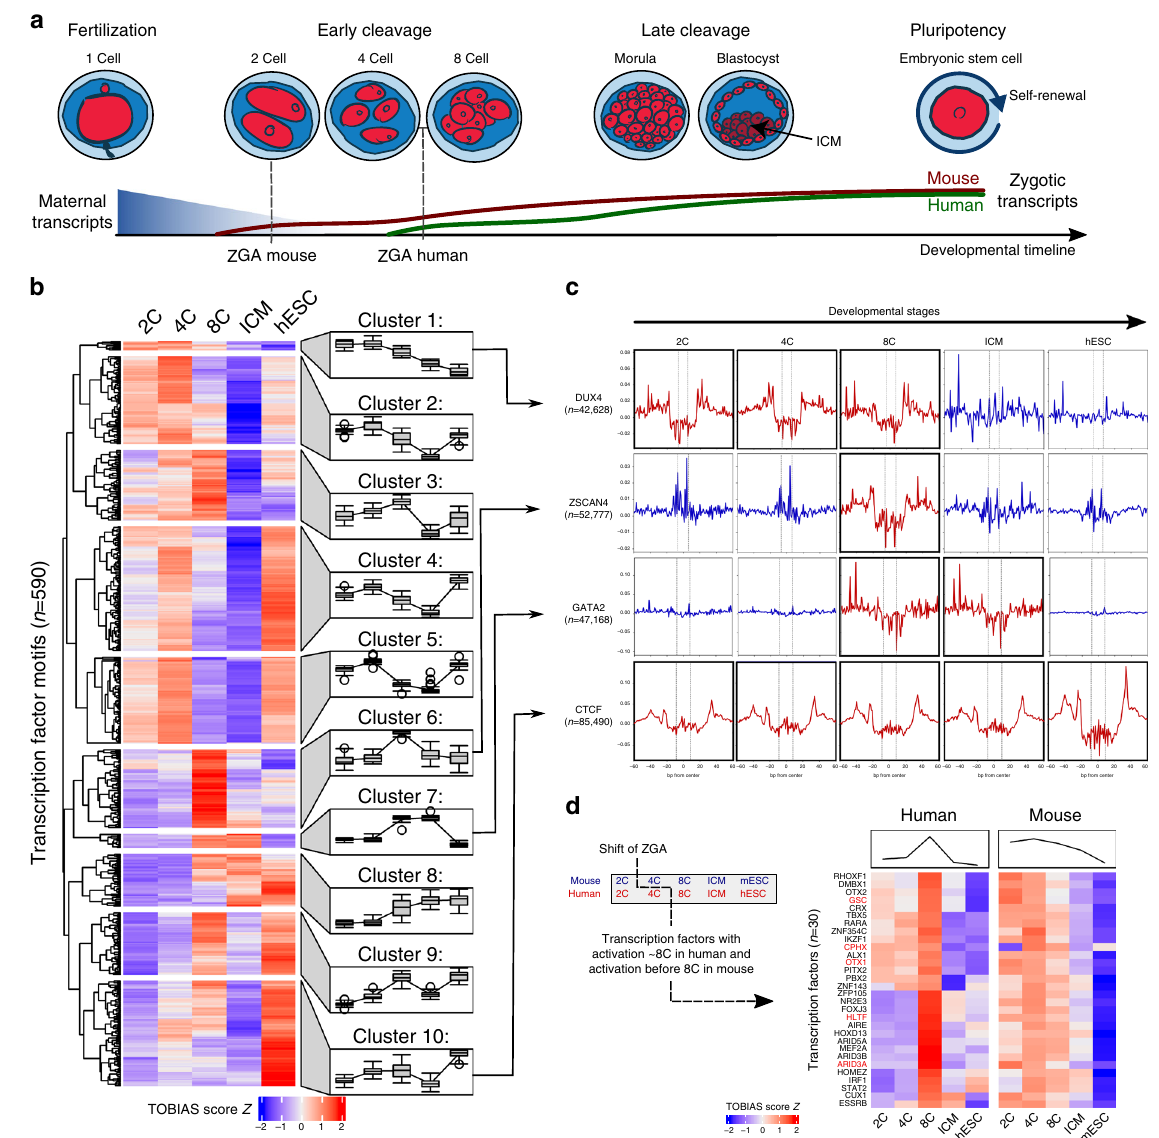
Fig. 2 Global changes in transcription factor binding throughout embryonic development. a Early embryonic development in human and mouse. While the fertilized egg undergoes a series of divisions, the maternal transcripts (blue curve) provided by the egg are depleted over time, and the zygotic genome is activated in waves (ZGA, red and green lines). ZGA initiates at the 2-cell stage in mouse and at the 4 – 8-cell stage in human. b Clustering of transcription factor activities throughout development. Each row represents one TF, each column a human developmental stage. TF activity scores from TOBIAS are Z - score transformed across rows. Blue color indicates low activity, red color indicates high activity. In order to visualize cluster trends, each cluster is associated with a mean trend line (left to right) and timepoint speci fi c boxplots respectively. Source data are available in the Source Data fi le. c Bias corrected ATAC-seq footprints. For selected TFs with known roles in early development originating from four clusters (arrows from b ), an aggregated footprinting plot matrix for all associated transcription factor binding sites is shown. Individual plots are centered around binding motifs ( n = asterisk (*) relates to the number of binding sites). Rows indicate TFs DUX4, ZSCAN4, GATA2, and CTCF; columns illustrate developmental stages from left to right. Active binding of the individual TFs is visible as depletion in the signal around the binding site (highlighted in red). See Supplementary Figure 4a for corresponding uncorrected footprints. d TF activity onset in human and mouse. Heatmaps show activity of known ZGA-related TFs for human (left) and mouse (right) across matched timepoints 2C/8C/ICM/hESC (mESC). Transcription factors with known roles in ZGA are highlighted in bold